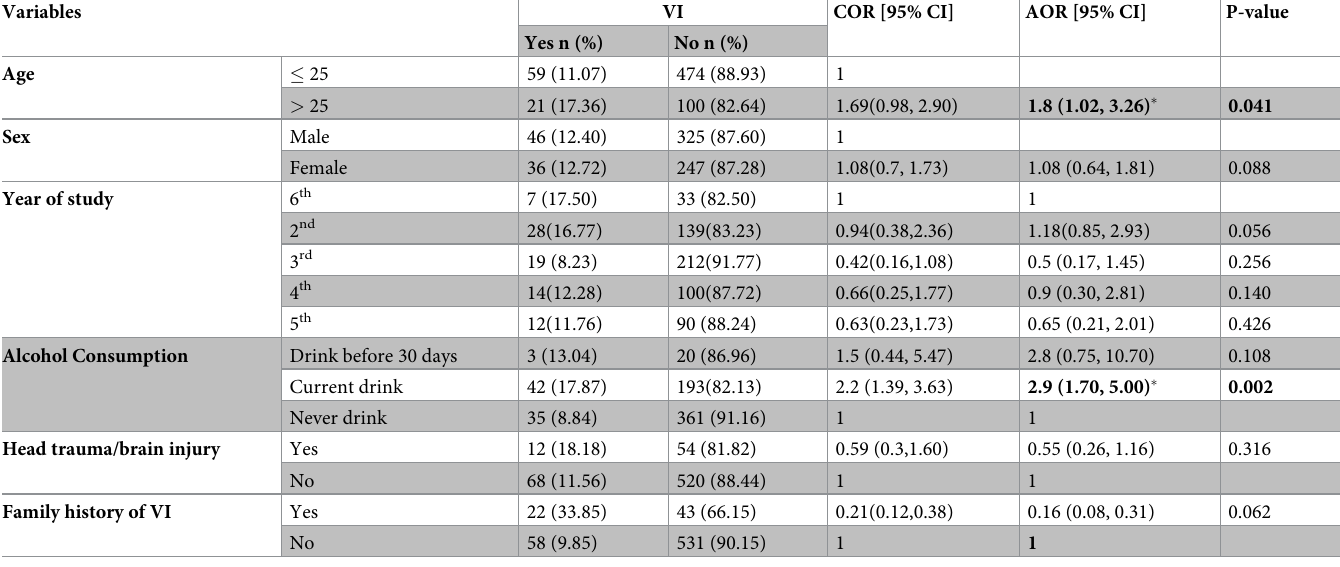
Table 4. Factors associated with visual impairment among medical and health science students in bivariable and multivariable logistic regression analyses, Univer- sity of Gondar, Northwest Ethiopia, 2020. Variables